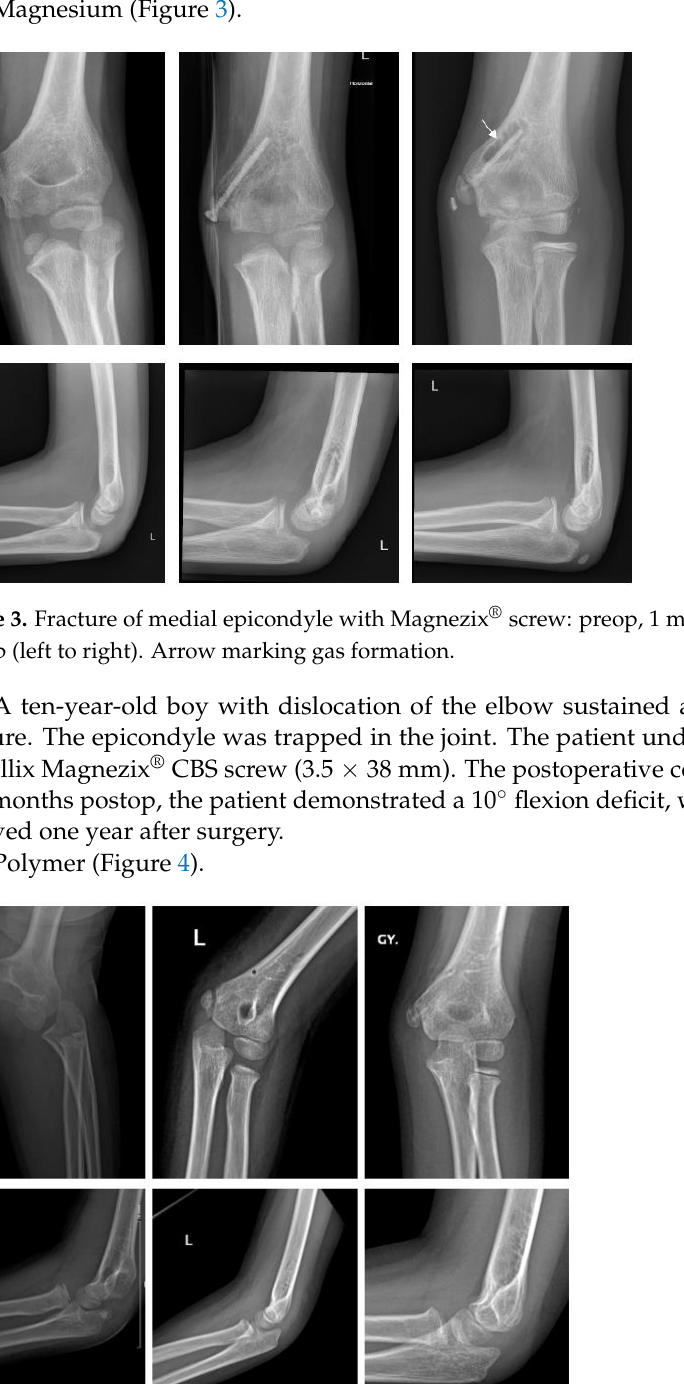
Figure 2. Fracture of tibi al tuberosity with ActivaScrew™: preop, 2 days postop, 6 months postop (left to right).